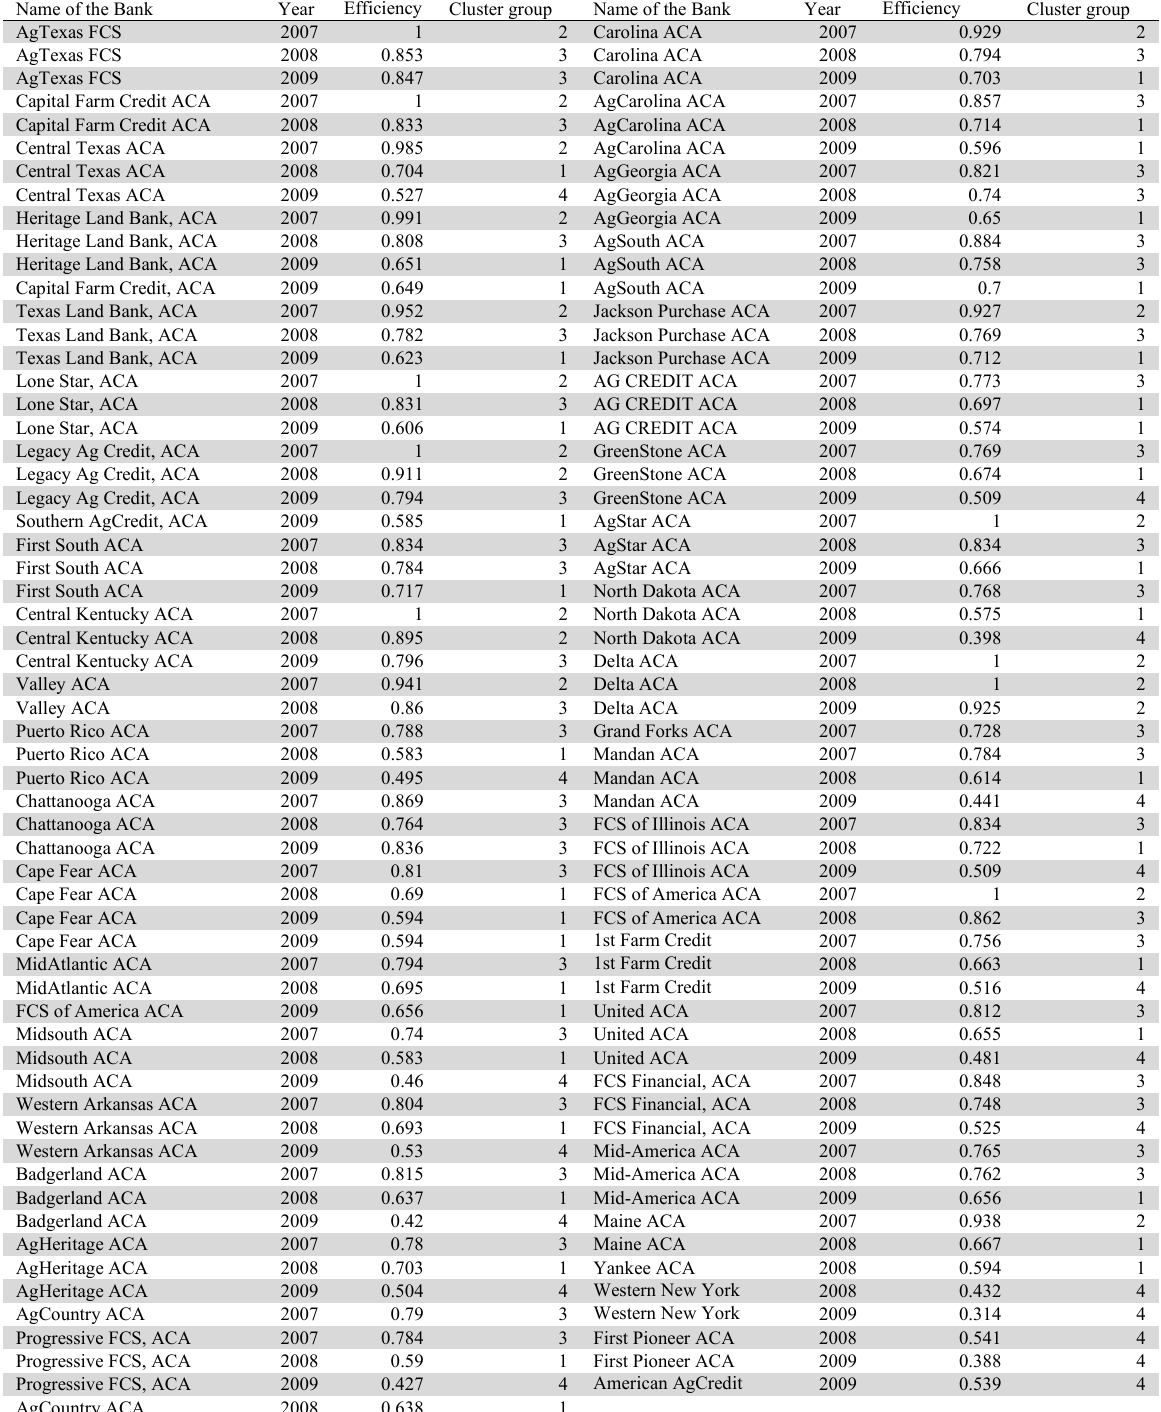
Efficiency Measure (2007-2009)